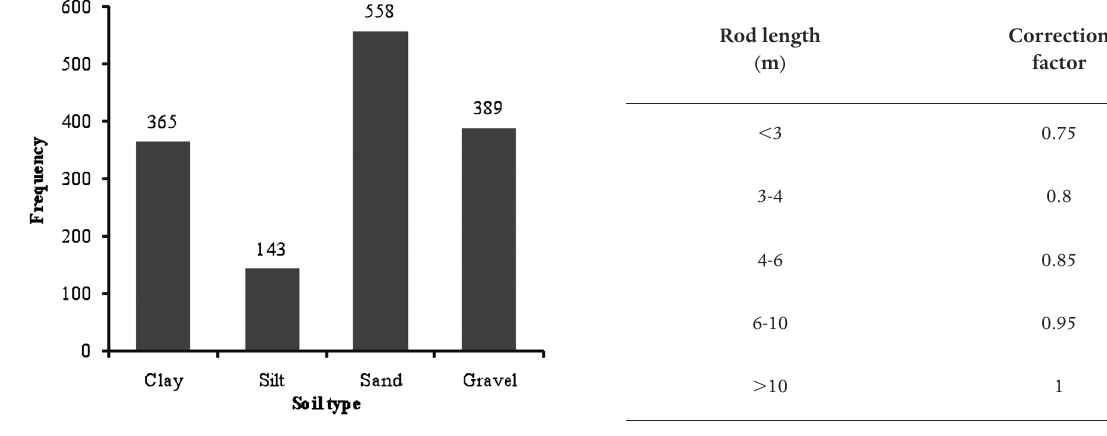
Figure 5. Frequency of data point based on soil type. Table 2. Rod length correction factors [Youd et al.